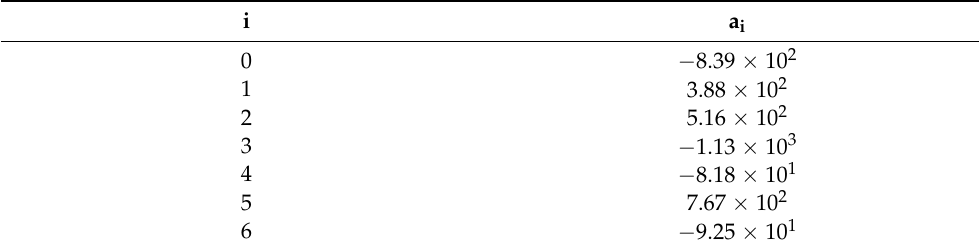
Table A7. Coefficients of the H 2 O-LiI enthalpy equation.